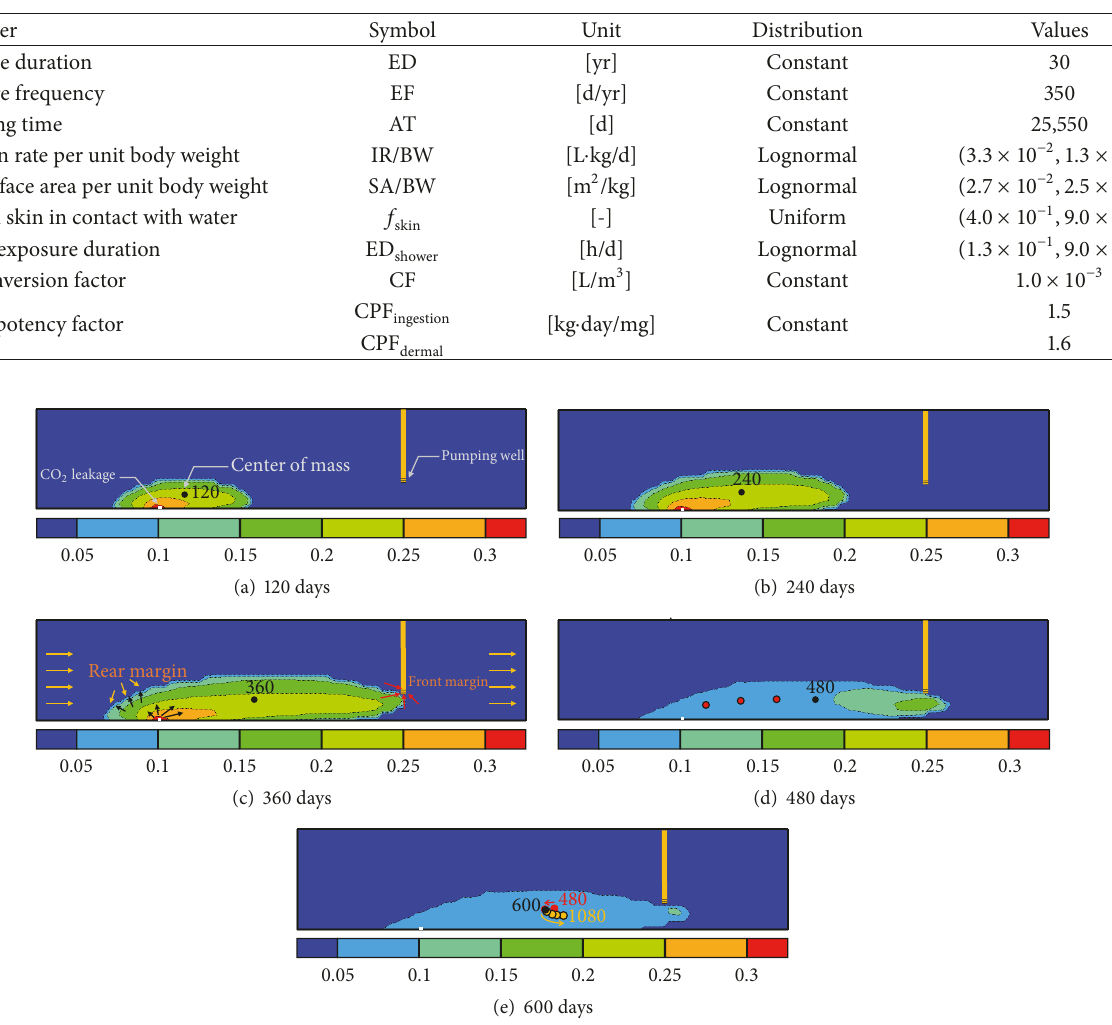
Figure 4: Saturation of leaked CO 2 at different times (120, 240, 360, 480, and 600 days). Red, black, and yellow circles with labels indicate the locations of mass center for CO 2 plume. Red circles in (d) and (e) stand for the evolution of the mass center in multiple times; yellow circles in (e) express the mass center from 600 to 1,080